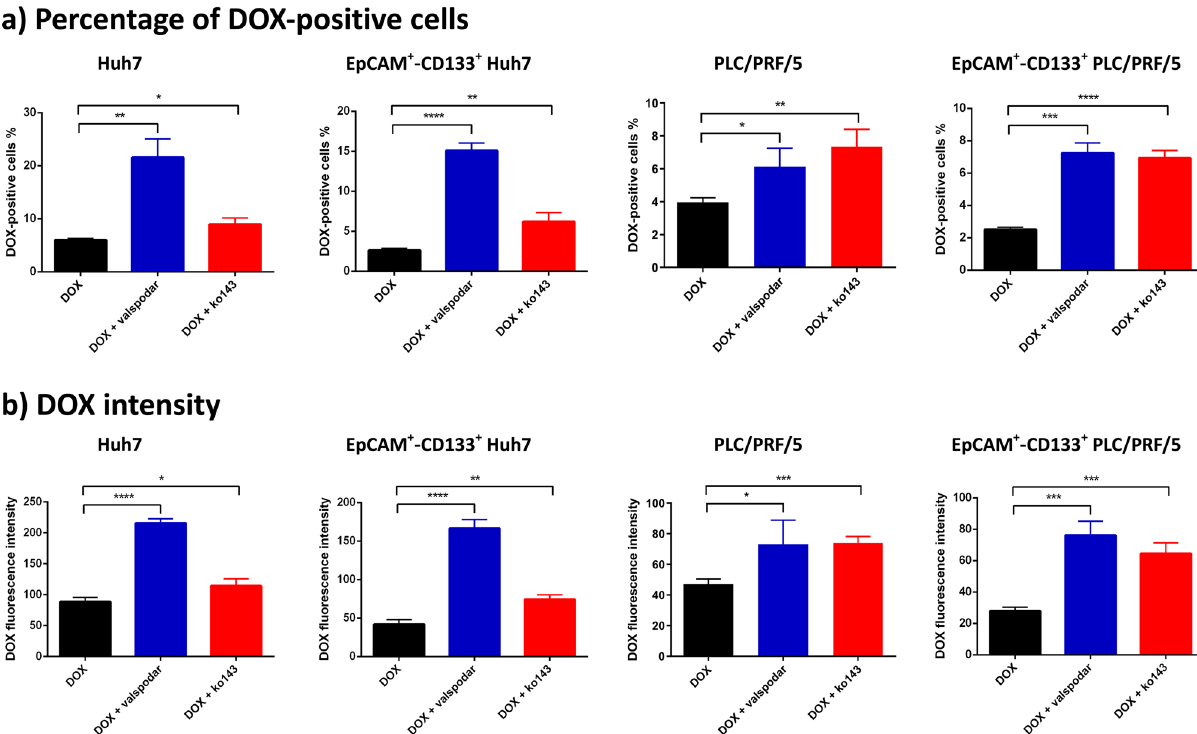
Figure 3. Involvement of MDR1 and ABCG2 in doxorubicin (DOX) efflux as determined by pharmacological inhibitors. The Huh7 or PLC/PRF/5 cells were treated with 200 nM or 100 nM of DOX in the presence or absence of MDR1 inhibitor valspodar (1 µM) or ABCG2 inhibitor ko143 (1 µM) for 24 h followed by flow cytometric analysis. ( a ) Percentage of DOX-positive cells; ( b ) DOX intensity followed by indicated treatments. Data shown are means ± SD, (n = 3). **** p < 0.0001; *** p < 0.001; ** p < 0.01; * p < 0.05; compared with DOX